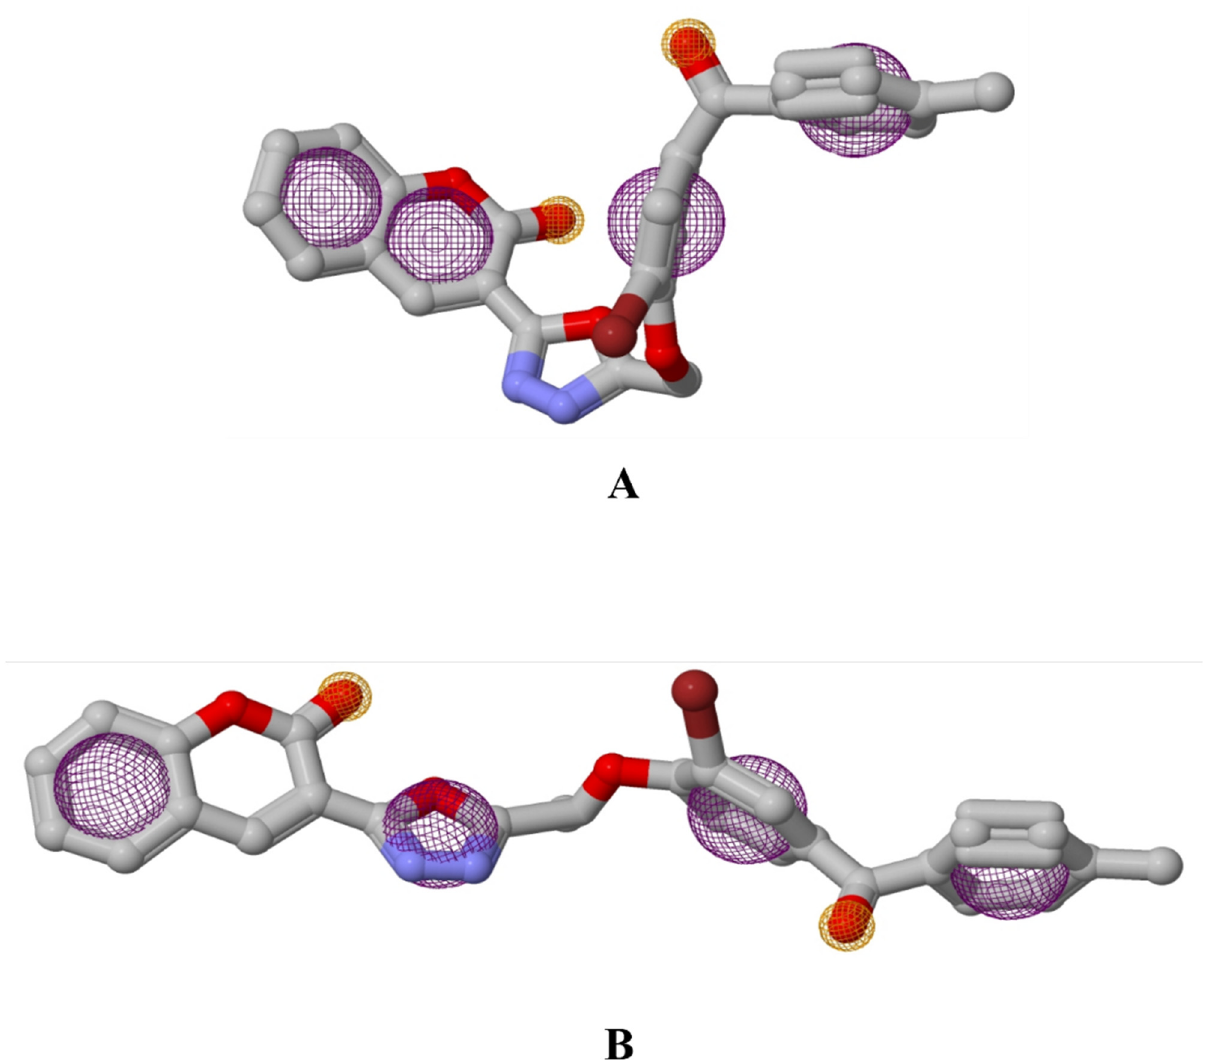
Figure 5. Pharmacophore models of CD-59 with ( A ) α -glucosidase and ( B ) α -amylase.